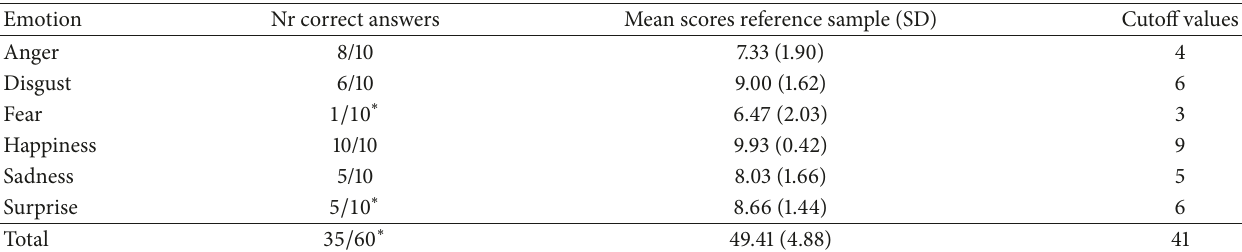
Table 1: The patient’s results for the “Ekman 60 Faces Test.”